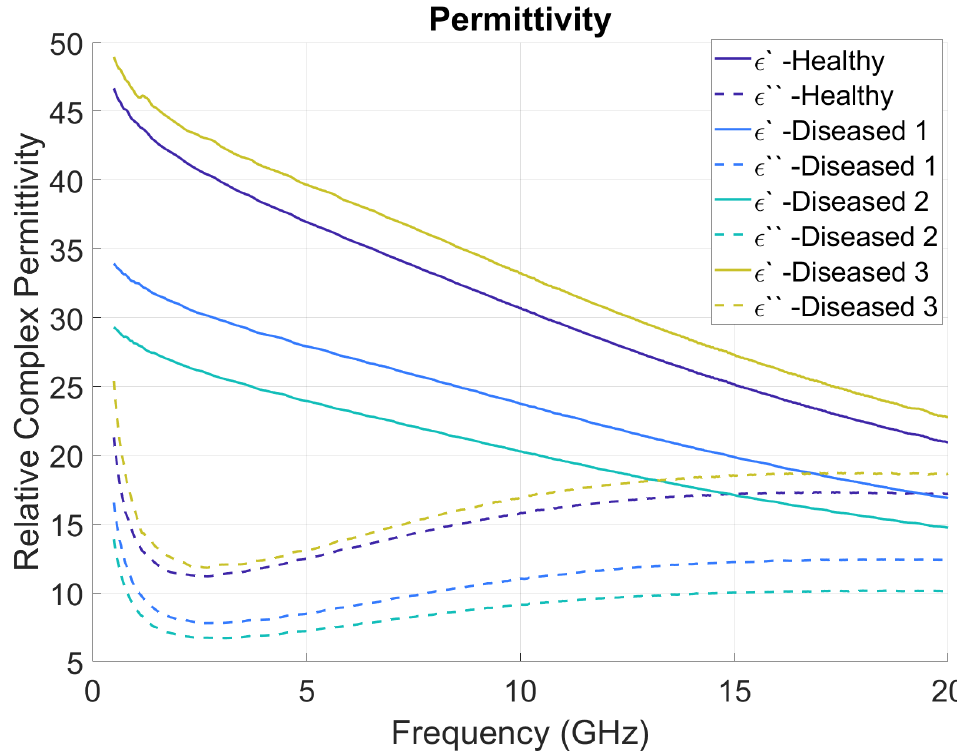
Figure 4. Average relative complex permittivity for healthy and diseased mice livers.